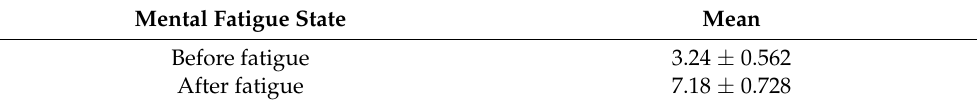
Table 4. Average score of KSS scale ( x ±